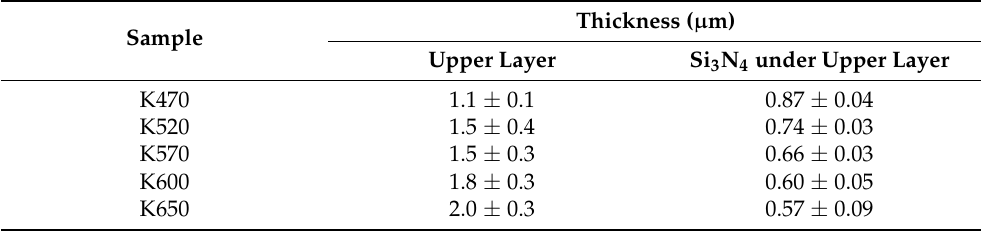
Figure 9. SEM surface morphology of the top surface of the doped layer for sample K600. The thicknesses of the upper layers for all of the samples are summarised in Table 4. For sample K470, the thickness of the Si 3 N 4 underneath the upper layer was less than the original thickness of 1 μm, which indicated that doping occurred, even though only a small amount was found on the Si 3 N 4 surface. For samples K520, K570, K600, and K650, the upper layer thicknesses could not be precisely determined, and they showed large errors due to their very rough surfaces. However, the estimated thickness obtained showed a linear relationship between thickness and the temperature used to heat the sub- strate. Additionally, the thickness of the Si 3 N 4 underneath the doped layer became smaller with an increase in substrate temperature. This finding indicated that the material target could react with Si 3 N 4 more thoroughly at higher temperatures. The refractive index and thickness, which were supposedly measured using a prism coupler, could not be meas- ured because of the uneven surface of the doped layer.